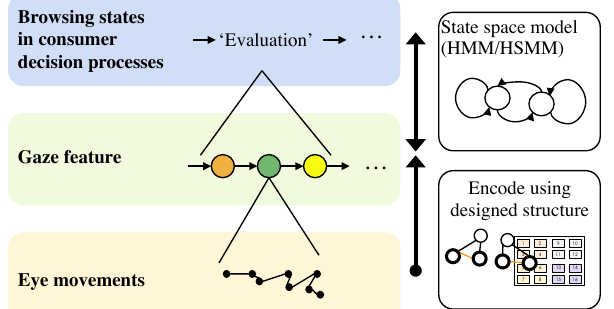
Figure 12 . Overview of the estimation method.